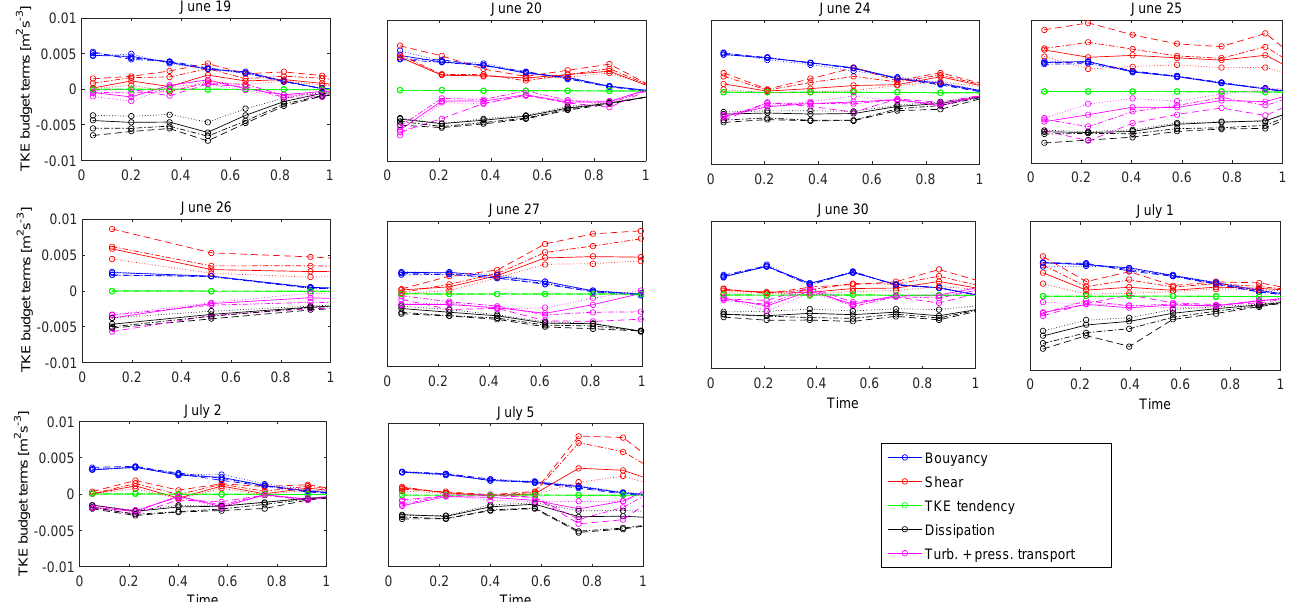
Figure 5. Turbulence kinetic energy budget terms are shown on the y axis as a function of normalized time for the afternoon period between 12:00UTC (denoted 0) and the time of zero-buoyancy flux (denoted 1). Here, dashed lines show the 2.23m results, dash-dotted 3.23m, full lines 5.23m and dotted lines 8.23m. The colors denote the different budget terms: buoyancy production (blue), shear production (red), dissipation (black), TKE tendency (green) and transport